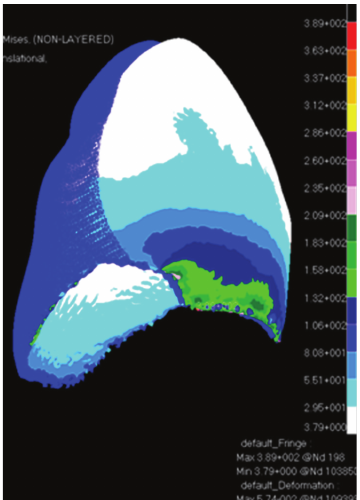
Figure 7: von Mises stress distribution (MPa) and strain (mm) of enamel tissues under lateral loading (100N).